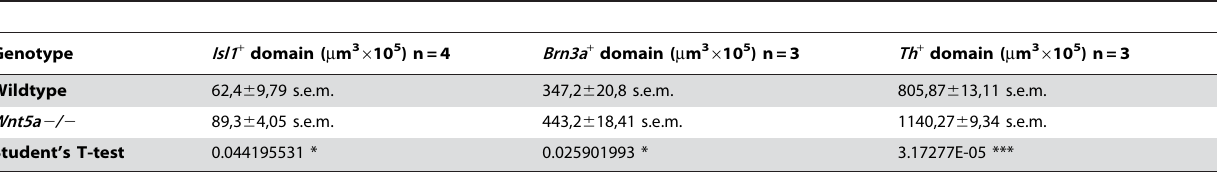
Table 1. The area occupied by the Islet1 + , Brn3a + or Th + domain in coronal sections is 30–40% greater in Wnt5a 2 / 2 mice at